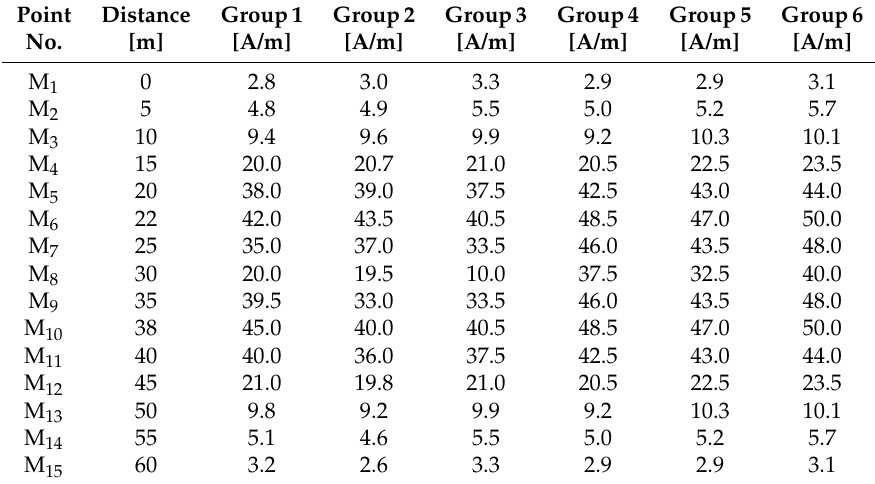
Table 2. The finite element method (FEM) simulation of the effective values of the magnetic field strength at 1.5 m above the ground.